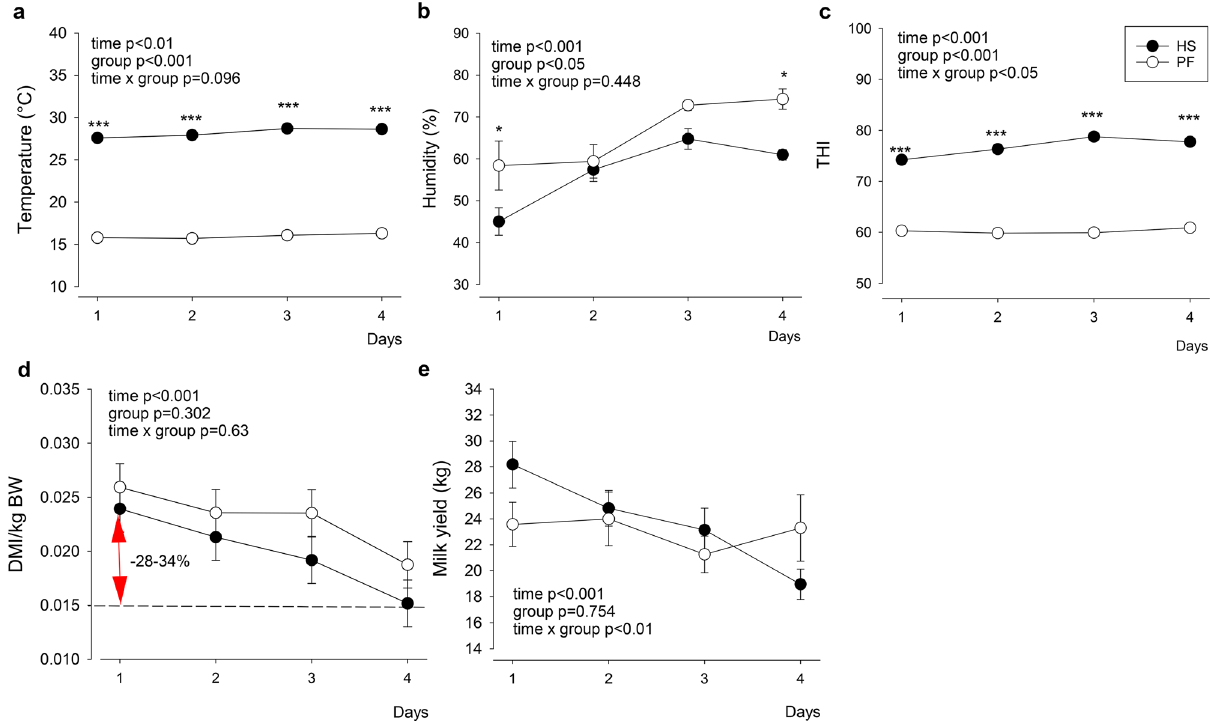
Figure 1. Temperature, humidity, feed intake, and milk yield during 4 days of heat stress (HS, full circles) or pair-fed (PF, open circles) conditions. ( a ) Ambient temperature, ( b ) humidity, ( c ) calculated temperature- humidity index (THI), ( d ) daily dry matter intake (DMI) per kg body weight (BW), and ( e ) daily milk yield. HS n = 5, PF n = 5. Data are given as LSM ± SE. * P < 0.05, *** P < 0.001. ANOVA (Tukey–Kramer). Graphs were created using Sigma plot (version 14.0; Systat Software, San Jose, CA,